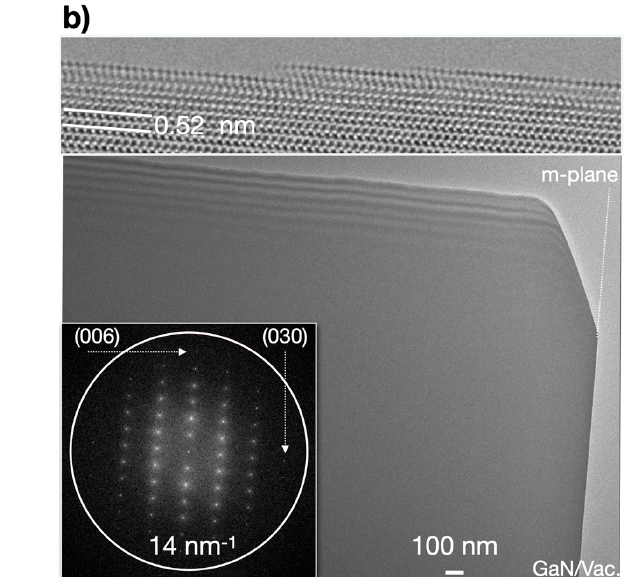
Figure 2. Microscope set-up and samples. ( a ) In a conventional microscope set-up, the depicted field of view (FOV) is limited by the aperture of the condenser system, which we used in combination with an electron beam of energy spread ∆ E mc = 0.6 eV. The inset shows the parameters for a Nelsonian illumination scheme with ∆ E mc = 0.1 eV. Calibration sample: gold on ultra-thin amorphous carbon. ( b ) A low-magnification image of the investigated GaN sample is shown in a-plane orientation together with a high-resolution image of the thin wedge at the top of the sample (basal plane) and its Fourier transform (inset). Contamination layers at surfaces were absent. In this work, the bright contrast surrounding the sample on a scale of 100 nm was investigated at the abrupt, nonpolar m-plane/vacuum interface.